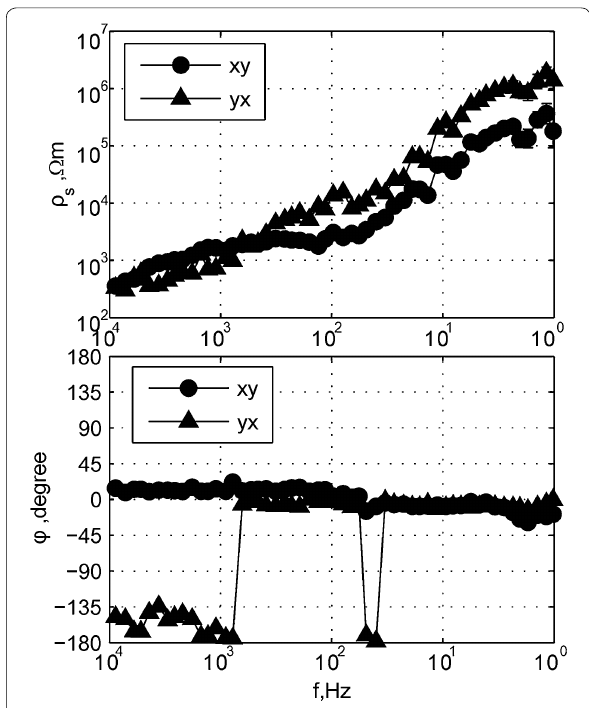
Fig. 14 Mine area EM noise evaluated by the AMT method. The Cagniard apparent resistivity and phase results prove that the near- field source noise, which is generated by the mine machinery and pipeline, is